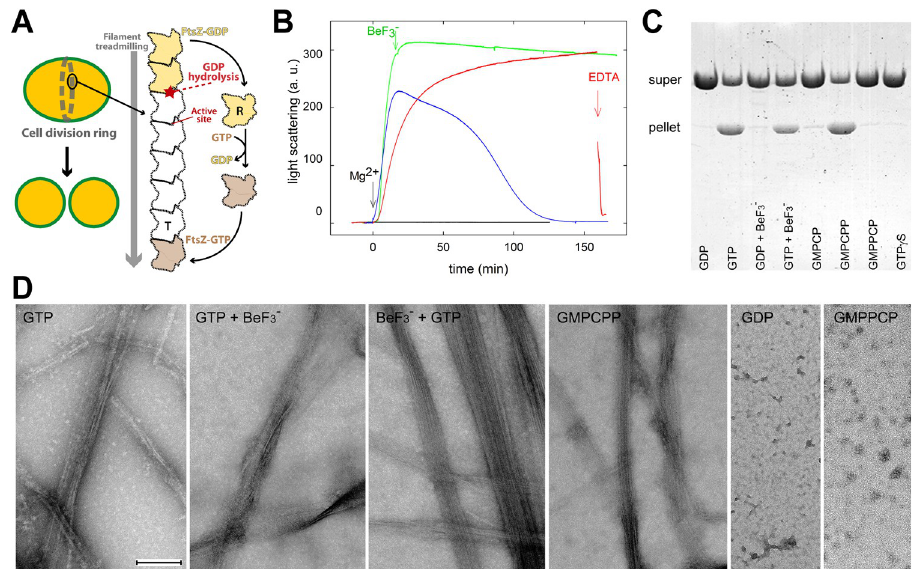
Fig 1. SaFtsZ filament assembly with GTP mimetics. (A) Schematic representation of the Z-ring, made of FtsZ filament clusters, in dividing S . aureus cells, next to a treadmilling FtsZ filament, drawn with only 8 subunits for simplicity. Brown and yellow subunits are bound to GTP and GDP, respectively. Nucleotide hydrolysis takes place inside the filament, although the nucleotide status of internal subunits (in white) is not specified by this scheme. The subunit conformational state is indicated by “T” (tense) for the filament and “R” (relaxed) for the monomer. (B) Stabilization of SaFtsZ assembly by BeF 3 − in solution. Light scattering at 350 nm was employed to monitor the formation of polymers by the SaFtsZ core (50 μ M) with 1 mM GTP (blue line), 1 mM GTP plus 1 mM BeF 3 − (red line), 1 mM GTP to which 1 mM BeF 3 − was added at the point indicated by the arrow (green line; named GTP+BeF 3 − below), and 1 mM GDP plus 1 mM BeF 3 − (black line). Assembly was triggered by addition of 10 mM MgCl 2 at time 0. Samples containing both GTP and 1 mM BeF 3 − disassembled with 20 mM EDTA (indicated by the red arrow). Numerical data for each curve can be found in S1 Data. (C) Sedimentation of polymers formed by SaFtsZ (31 μ M) with different guanine nucleotides and mimetics (1 mM each, except 0.1 mM GMPCP and GMPCPP); pellet and supernatant samples were consecutively loaded with a 15-min time shift in SDS-PAGE. (D) Representative electron micrographs of polymers formed by SaFtsZ (31 μ M) with different nucleotide mimetics, in negative stain. Incubation time was 30 min with GTP and GTP+BeF 3 − (green line in panel A), 24 h with BeF 3 − +GTP added 5 min later, 80 min with GMPCPP, 2 h with GDP and GMPPCP, to visualize polymer structures at maximal formation. The bar indicates 200